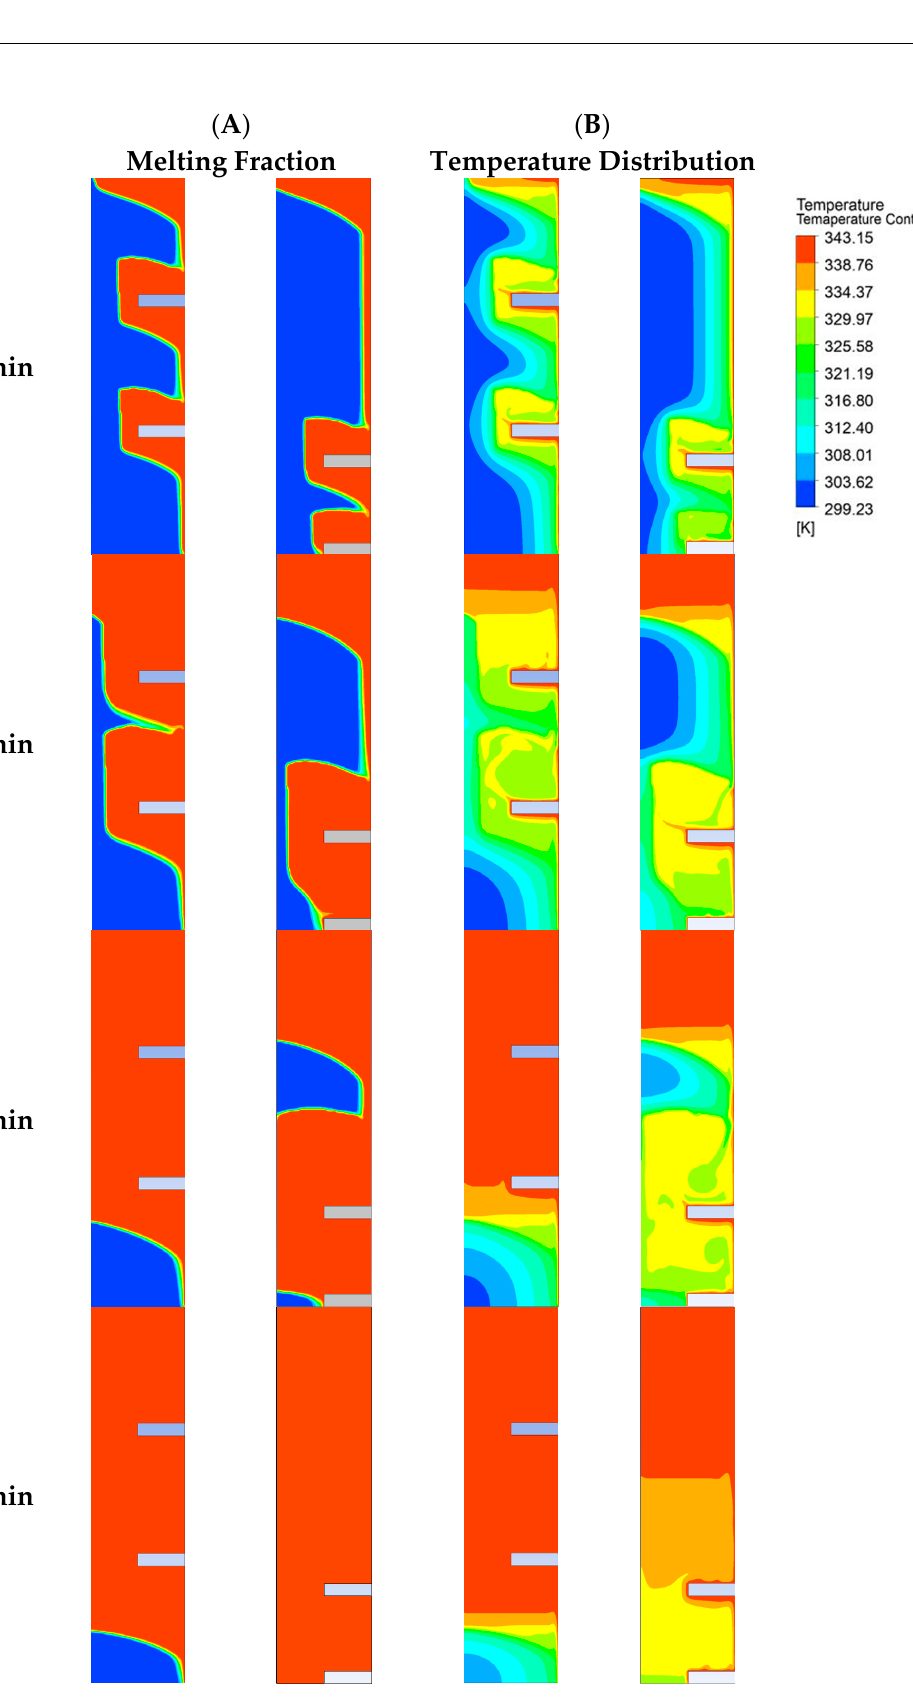
Figure 9. ( A ) Temporal evolution of melting front, ( B ) temperature distribution during melting process ( left ; symmetric, right ; asymmetric at pitch of 24 mm).